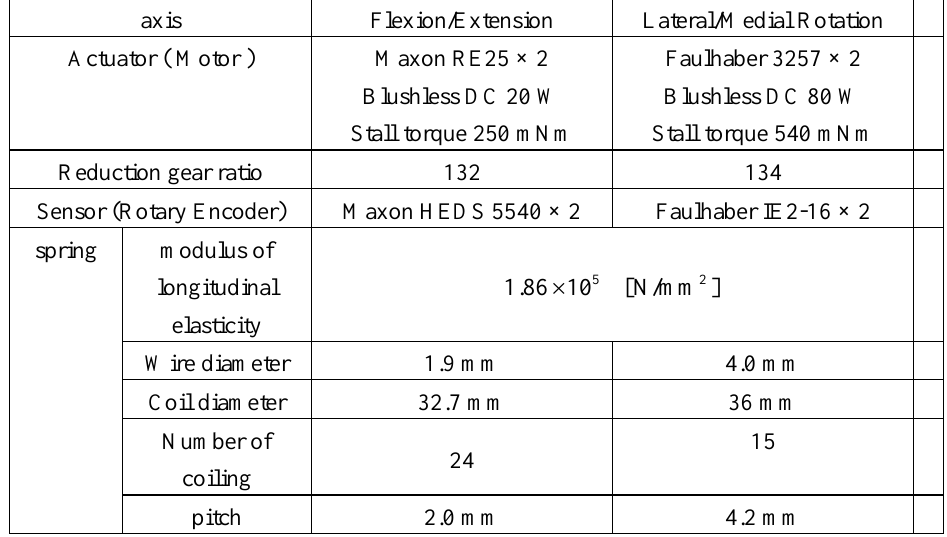
Table 1. Specification of motors and springs used.